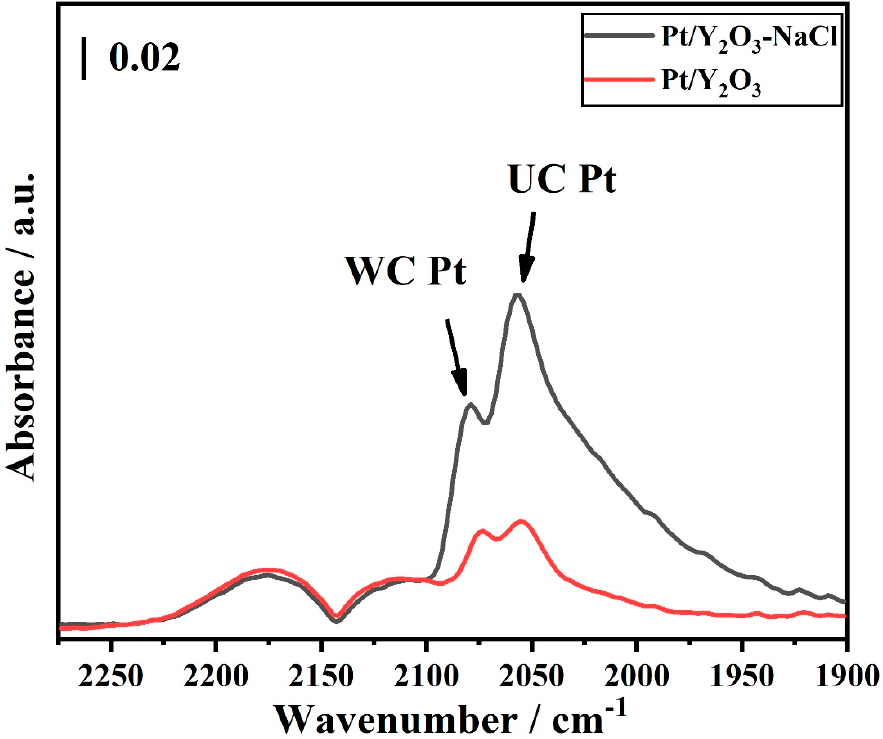
Figure 10. In situ DRIFTS of Pt/Y 2 O 3 and Pt/Y 2 O 3 -NaCl catalysts after 30 min CO